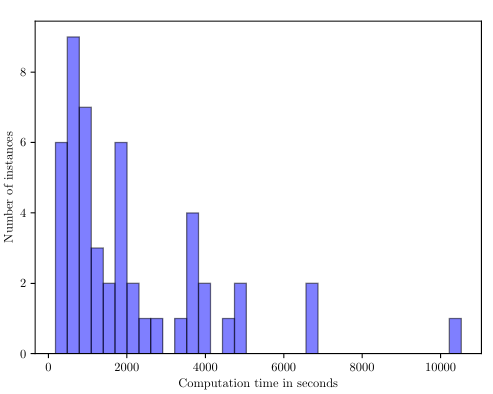
Figure 2. Histogram of run times to compute the optimal solution of each SAA instance for the small-scale